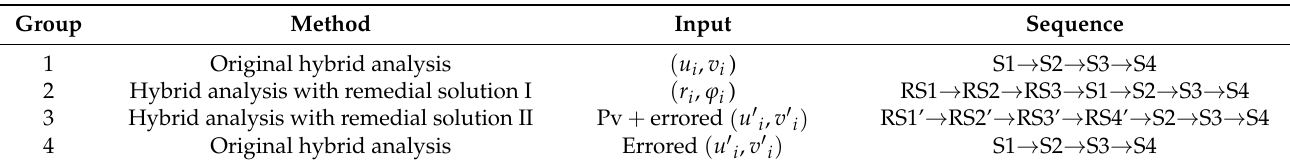
Table 2. Groups of hybrid analyses.